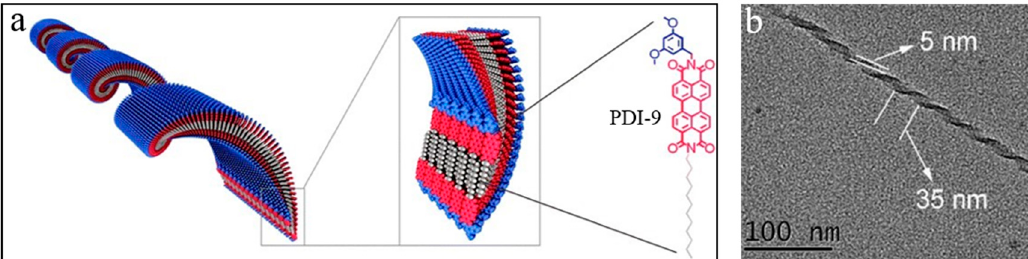
Figure 10. ( a ). Schematic illustration showing the molecular self-assembly of PDI-9 leading to formation of nanocoils; ( b ). TEM image of a single nanocoil formed from PDI-9 [47].